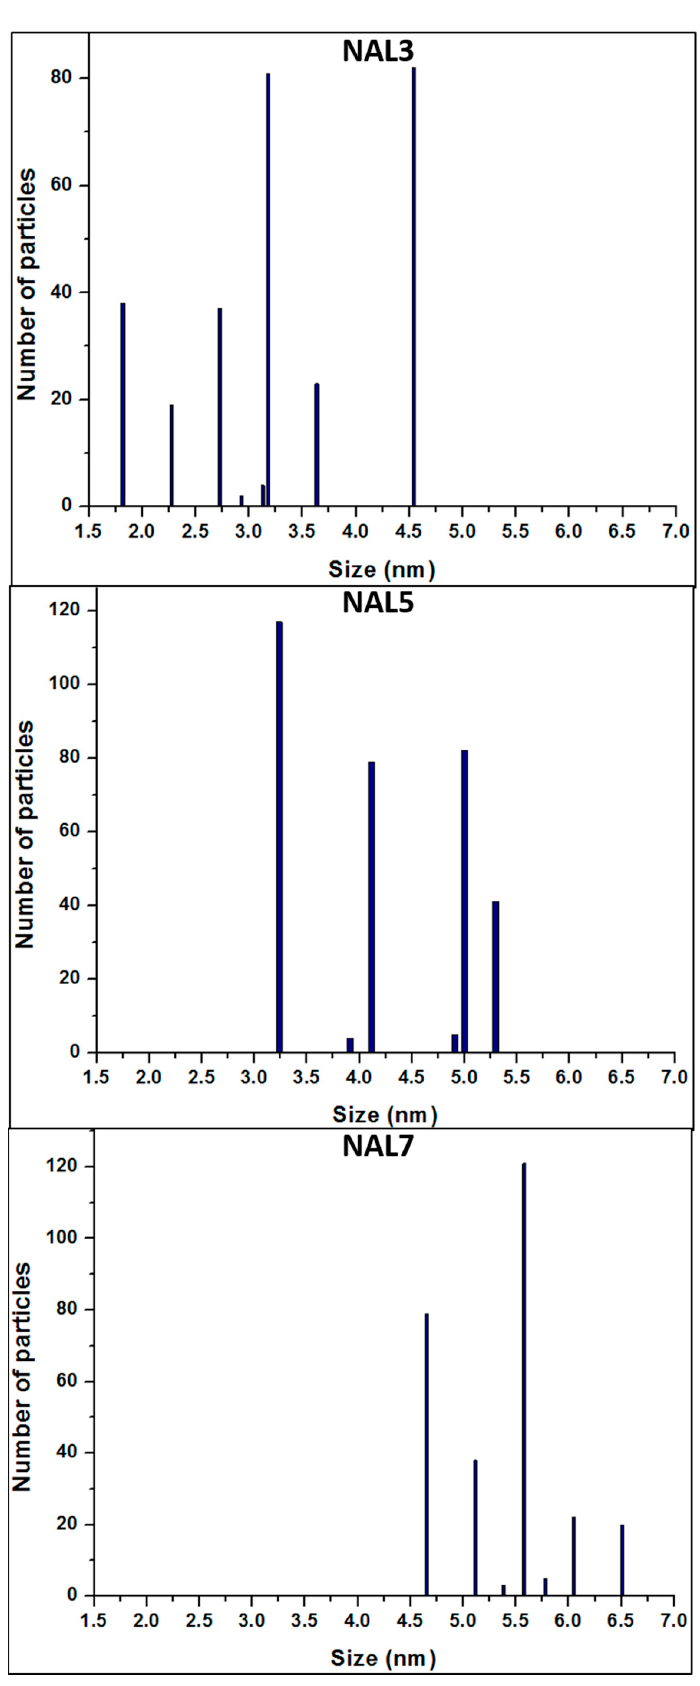
Figure 4. Histograms of particle size in Ni/ γ‐ Al 2 O 3 catalysts: NAL3, NAL5, and NAL7.